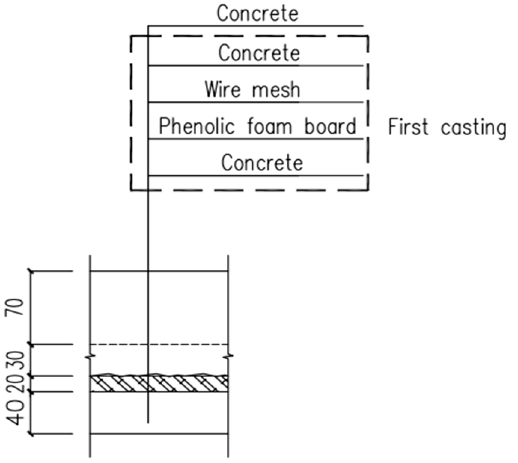
Figure 1. Schematic diagram of sandwich laminated floor slab interlayer structure.